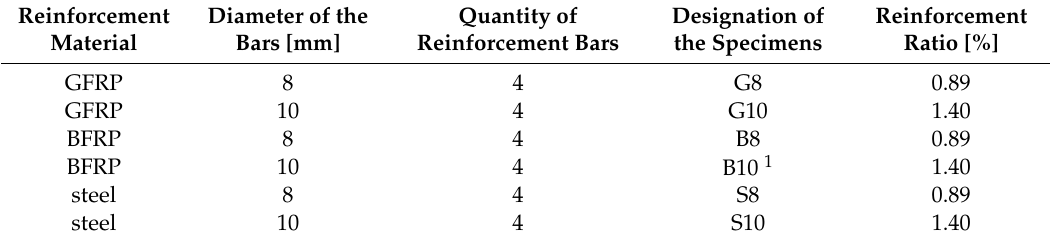
Table 1. Summary of analyzed reinforced specimens.